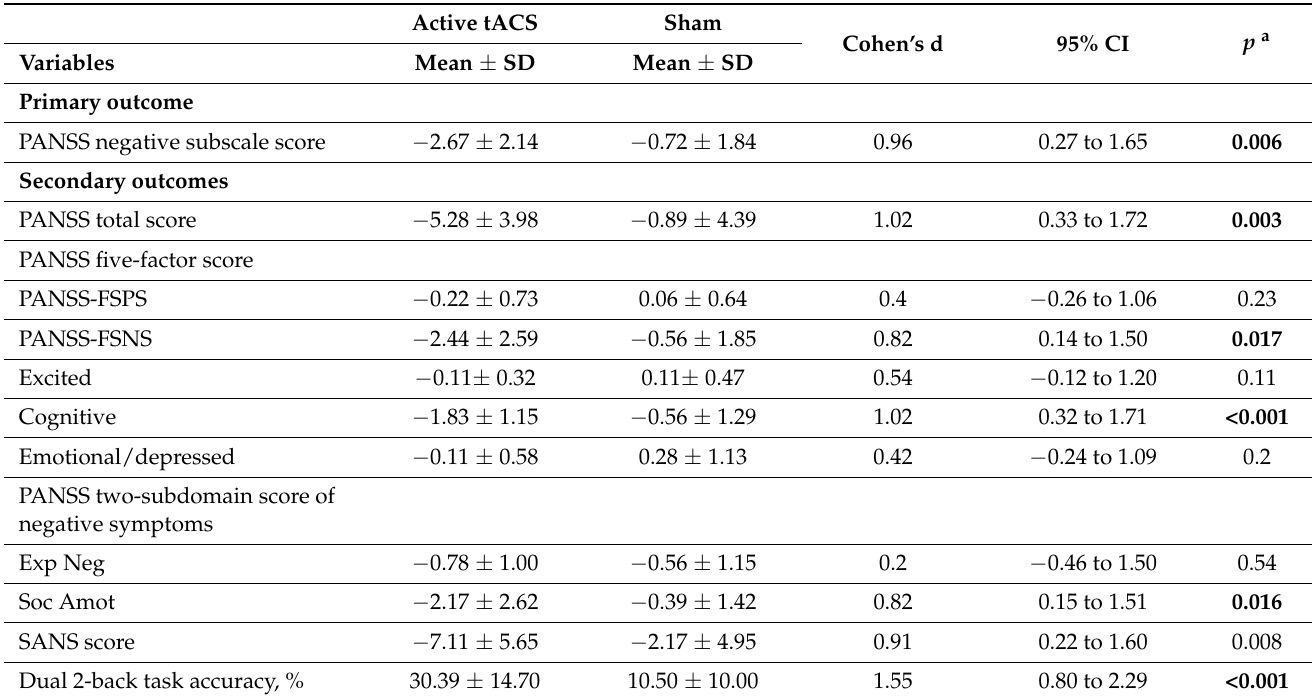
Table 2. Changes in the primary and secondary outcomes after 10 sessions of tACS (n = 18) or sham stimulation (n = 18) in the participants.